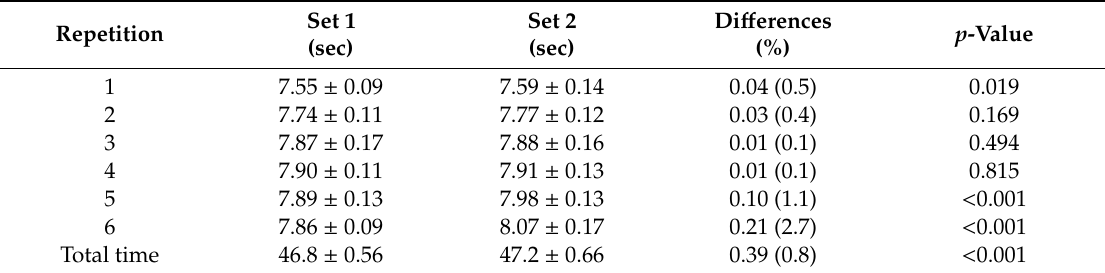
Table 3. Time scores in Sets 1 and 2 of the Curved Sprint Test (CST) and their di ff erences.